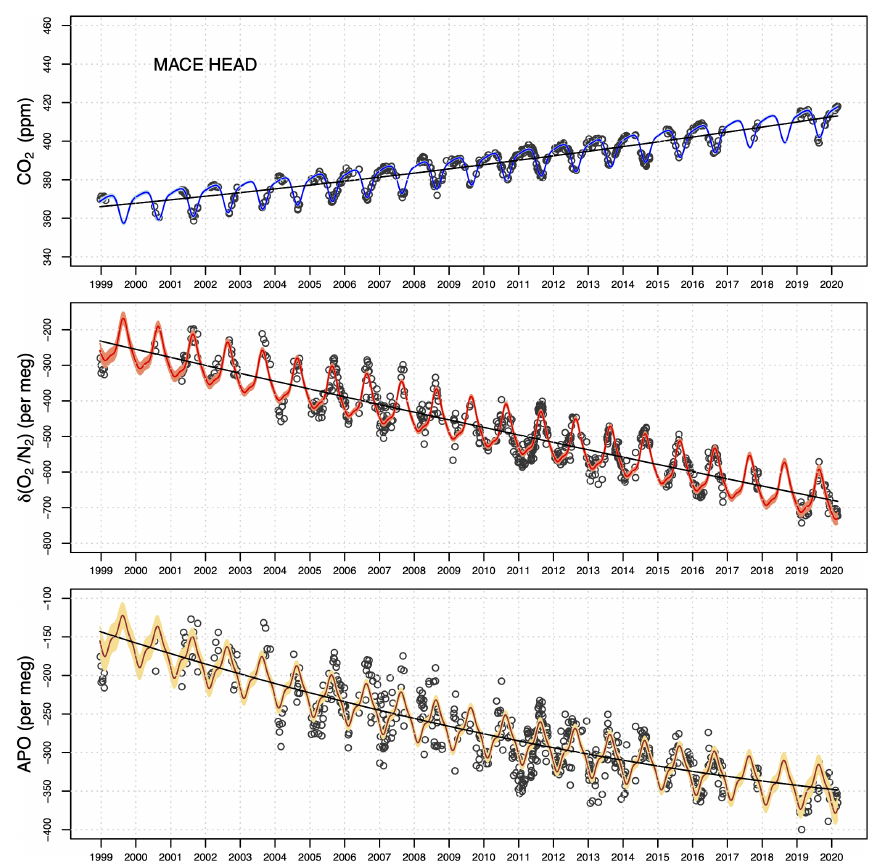
Figure 8. As for Fig. 7 but for Mace Head